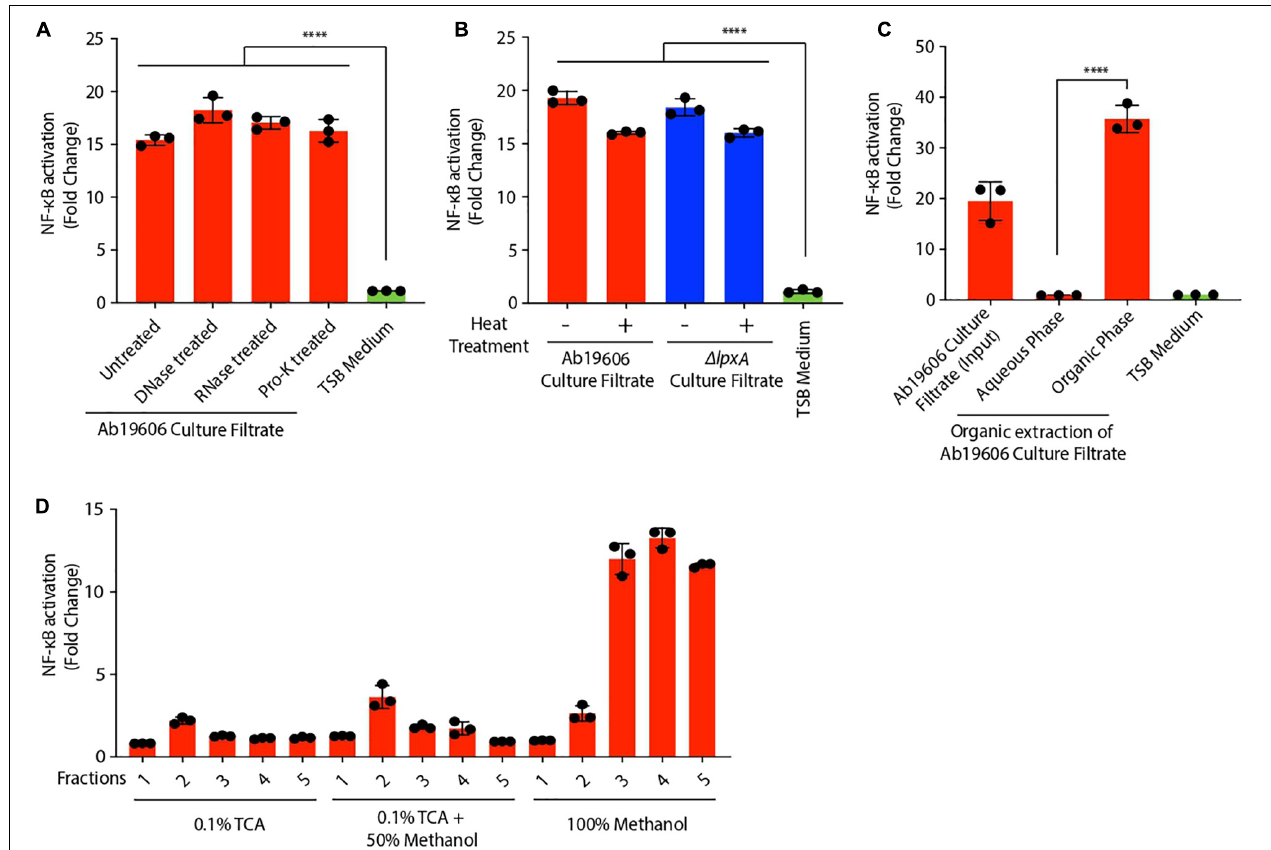
FIGURE 3 | Characterization of inflammatory factors in Acinetobacter baumannii culture filtrate. (A,B) Culture filtrate from wildtype A. baumannii (Ab19606) was treated with DNase, RNase, proteinase K (Pro-K) or heat treated. THP1-XBlue reporter cells were exposed to untreated and the treated culture filtrate. Levels of SEAP were assessed after 24 h of culture filtrate treatment. The experiments were done in triplicates. Error bars represent standard deviation. One-way ANOVA with Tukey’s multiple comparisons test. (C) Organic extraction was performed on the culture filtrate from wildtype A. baumannii (Ab19606). THP1-XBlue reporter cells were treated with the Aqueous and organic phases. TSB medium was used to grow the bacterial cultures and fresh TSB medium treatment served as the negative control. Levels of SEAP were assessed after 24 h from the beginning of the treatment. The experiments were done in triplicates. Error bars represent standard deviation. One-way ANOVA with Tukey’s multiple comparisons test. (D) Biochemical fractionation was performed on the culture filtrate from wildtype A. baumannii (Ab19606). THP1-XBlue reporter cells were treated with the indicated fractions. Levels of SEAP were assessed after 24 h from the beginning of the treatment. The experiments were done in triplicates. Error bars represent standard deviation. One-way ANOVA with Tukey’s multiple comparisons test. All the experiments were performed three times independently. * P < 0.05, ** P < 0.01, *** P < 0.001, **** P <